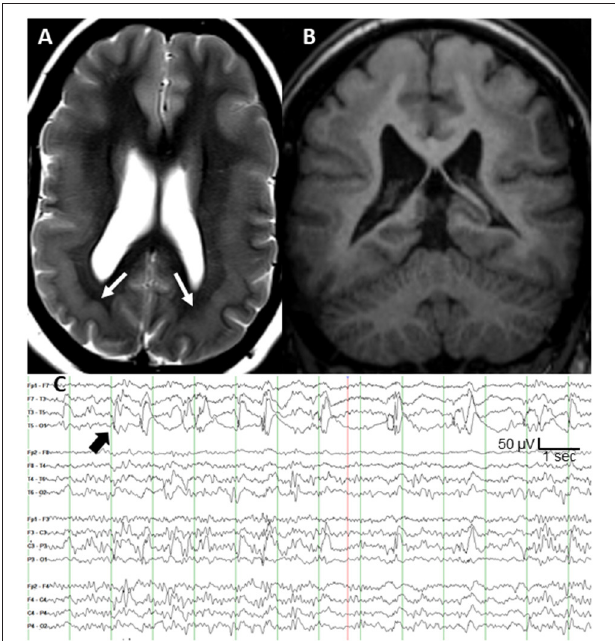
FIGURE 1 | (A) T2-weighted axial MRI of bilateral posterior band heterotopia (white arrows), (B) T1-weighted coronal MRI, and (C) scalp interictal EEG with left posterior temporal spikes (black arrow).